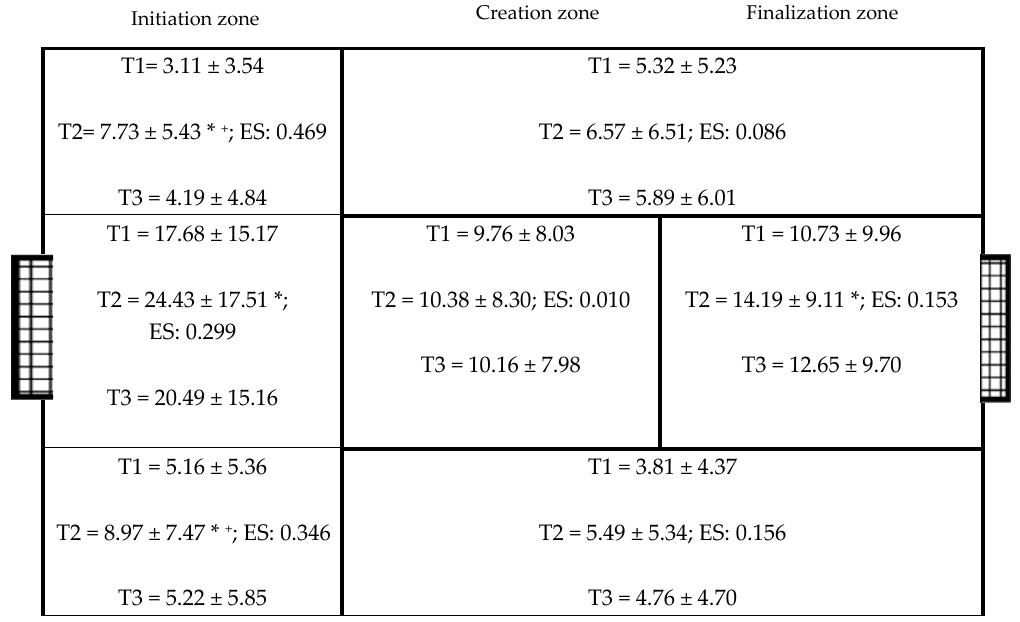
Figure 2. Zone where possession ends * Statistically significant differences between T1 and T3. + Statistically significant differences between T2 and T3. ES: effect size ( η 2 ).